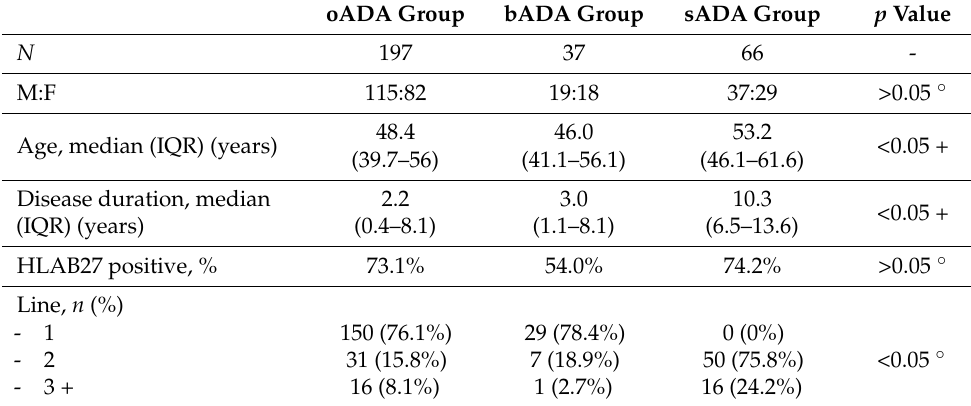
Table 4. AxSpA cohort characteristics.